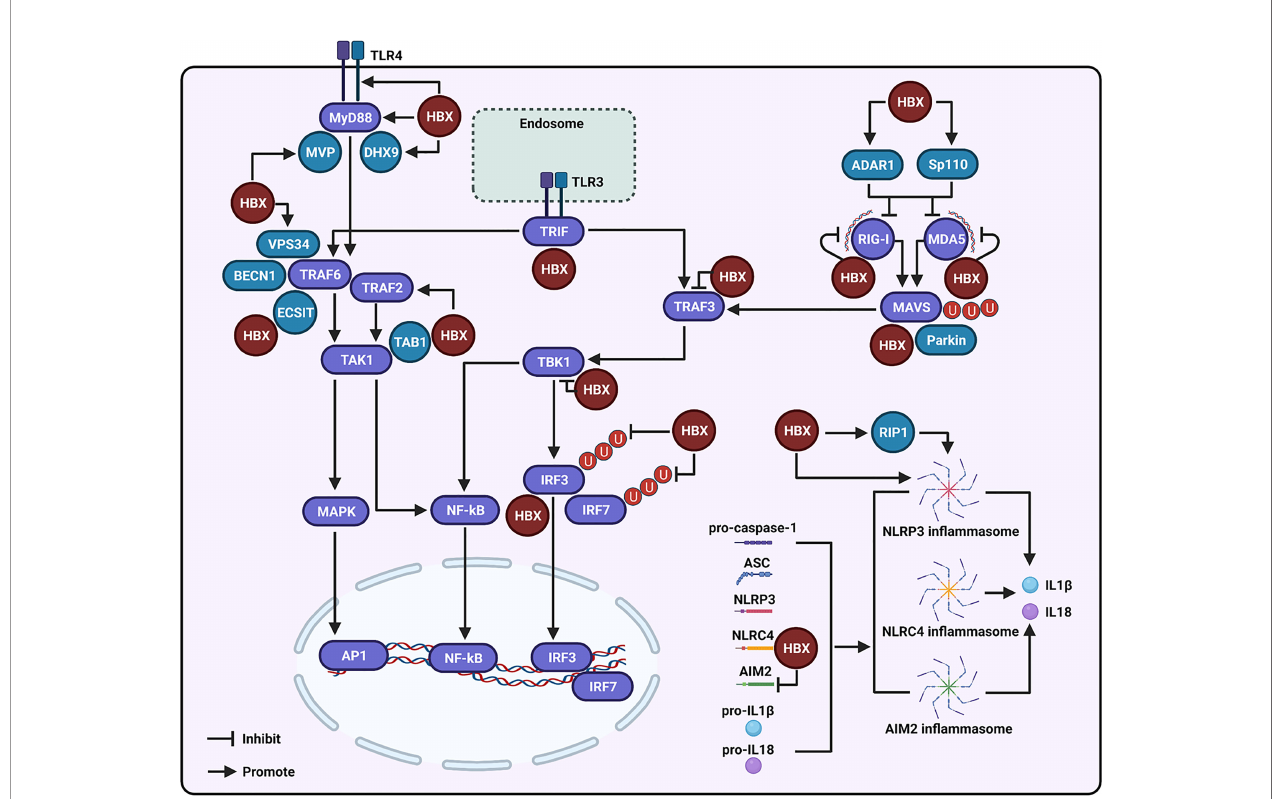
FIGURE 1 | Regulation of the hepatitisB virus X protein(HBX) on thetoll-like receptor(TLR),retinoic acid induciblegene I (RIG-I)-likereceptor (RLR),and NOD-likereceptor (NLR) signaling-associated molecules. Duringthe modulation ofTLR signalingmediatedby HBX, the viral protein can promotethe expression of TLR4 and myeloid differentiation primaryresponse 88 (MyD88),and enhance the levelsof themajor vaultprotein (MVP) and DExH-box RNA helicase 9 (DHX9),which may further interact with MyD88 to regulate the innate immune response. HBXcan activate the tumornecrosisfactor (TNF) receptor-associatedfactor (TRAF)-2/transforming growth factor-activated kinase-1 (TAK1) signalingpathway.HBX isalso able to interact with TAB1, and the interaction may affect the function of TAK1. The viralprotein iscapableof interactingwith the evolutionarilyconserved signalingintermediate inTollpathway (ECSIT),which is a partner ofTRAF6. The viral proteinalso contributes to the interaction ofvacuolar protein sorting 34 (VPS34)with Beclin 1 (BECN1) and TRAF6. HBX interacts with toll-interleukin-1 receptor(TIR)-domain-containing adaptor-inducing IFN- b (TRIF), a downstream molecule ofTLR3. HBXcan bind to RIG-I, melanoma differentiation-associated 5 (MDA5), andmitochondrial antiviral signaling(MAVS) to inhibitRLR signaling. Adenosine deaminaseacting onRNA 1 (ADAR1) and speckledat110 kDa (Sp110) may participate inthe inhibition ofRIG-I andMDA5 mediated by HBX. Parkin isinvolved inthe degradation of MAVS inducedby HBX. Besides these, HBXalso interacts with TRAF3 andTBK1to inhibittheiractivities. HBX can bindto IRF3 and inhibit the ubiquitination of IRF3 and IRF7 at the lysine 63 sites to suppress their activation.During themodulation of NLR signaling, HBX can activate the NLRfamilypyrin domain-containing 3 (NLRP-3) in fl ammasome. RIP1 may beinvolved inthe activation of NLRP3 in fl ammasome mediatedby HBX. Moreover,HBXcan interact with the NLR with CARD domain- containing 4 (NLRC4) and through this interaction,HBXmay in fl uence the NLRC4 in fl ammasome. The viral protein can also inhibit the expression of absent-in-melanoma-2 (AIM2) andmay further affect the AIM2in fl